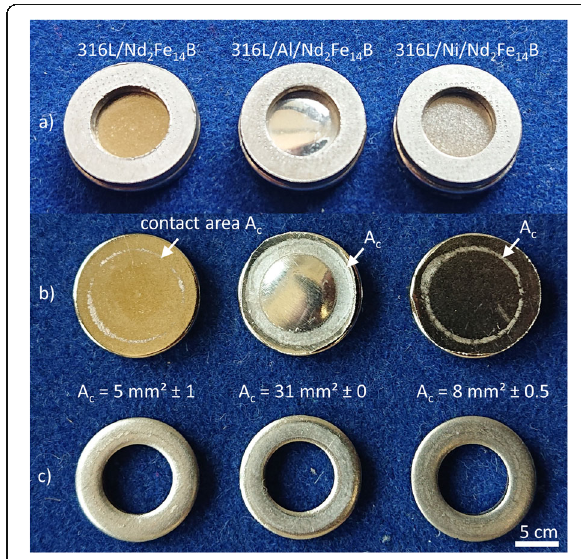
Fig. 8 Ultrasonically welded joints a different hybrid material systems and fracture surfaces of b the lower joining partner and c the 316L flat ring